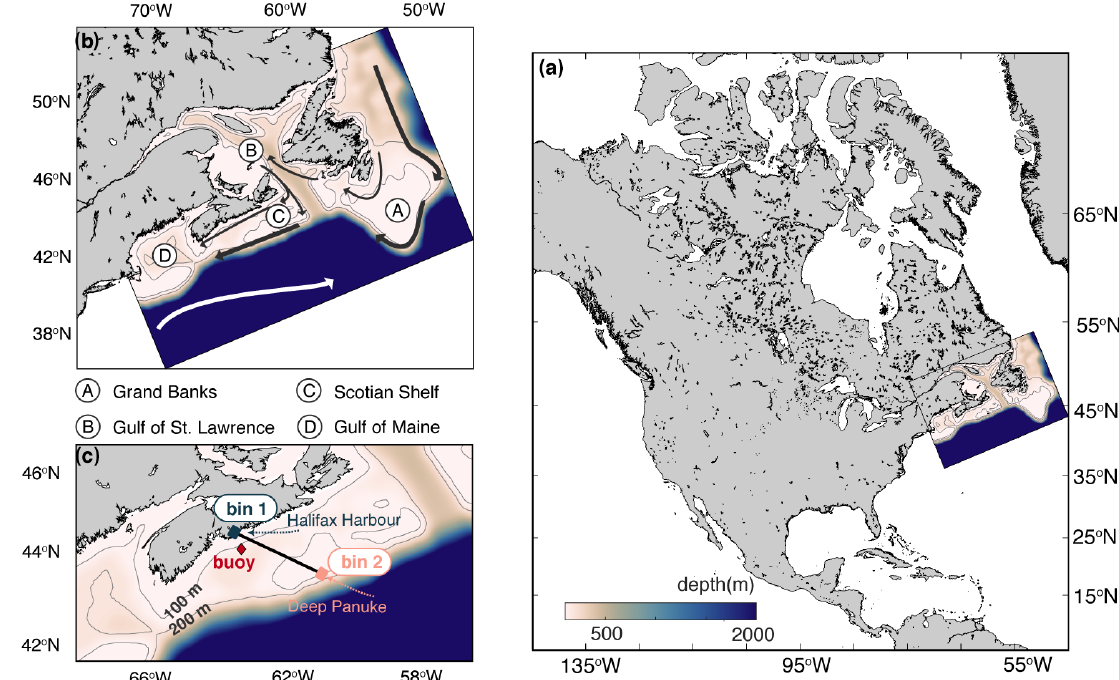
Figure 1. Bathymetric maps of the model domain. (a) Map of North America, including the location of the model domain. (b) A zoomed-in map of the model domain with mean current locations. (c) Zoomed-in map of the Scotian Shelf, which indicates the location of the CARIOCA buoy (red diamond) and the Atlantic Condor transect (black line). Bin 1 (Halifax Harbour) and bin 2 (Deep Panuke) are used for analyses of spatial variability. All maps show the 100 and 200m